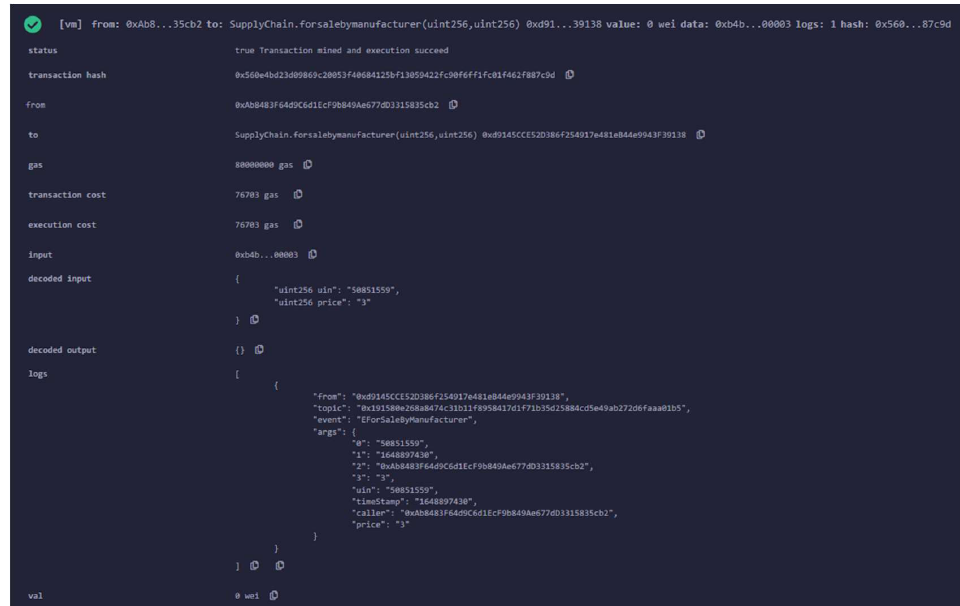
Fig. 9. Product on sale by